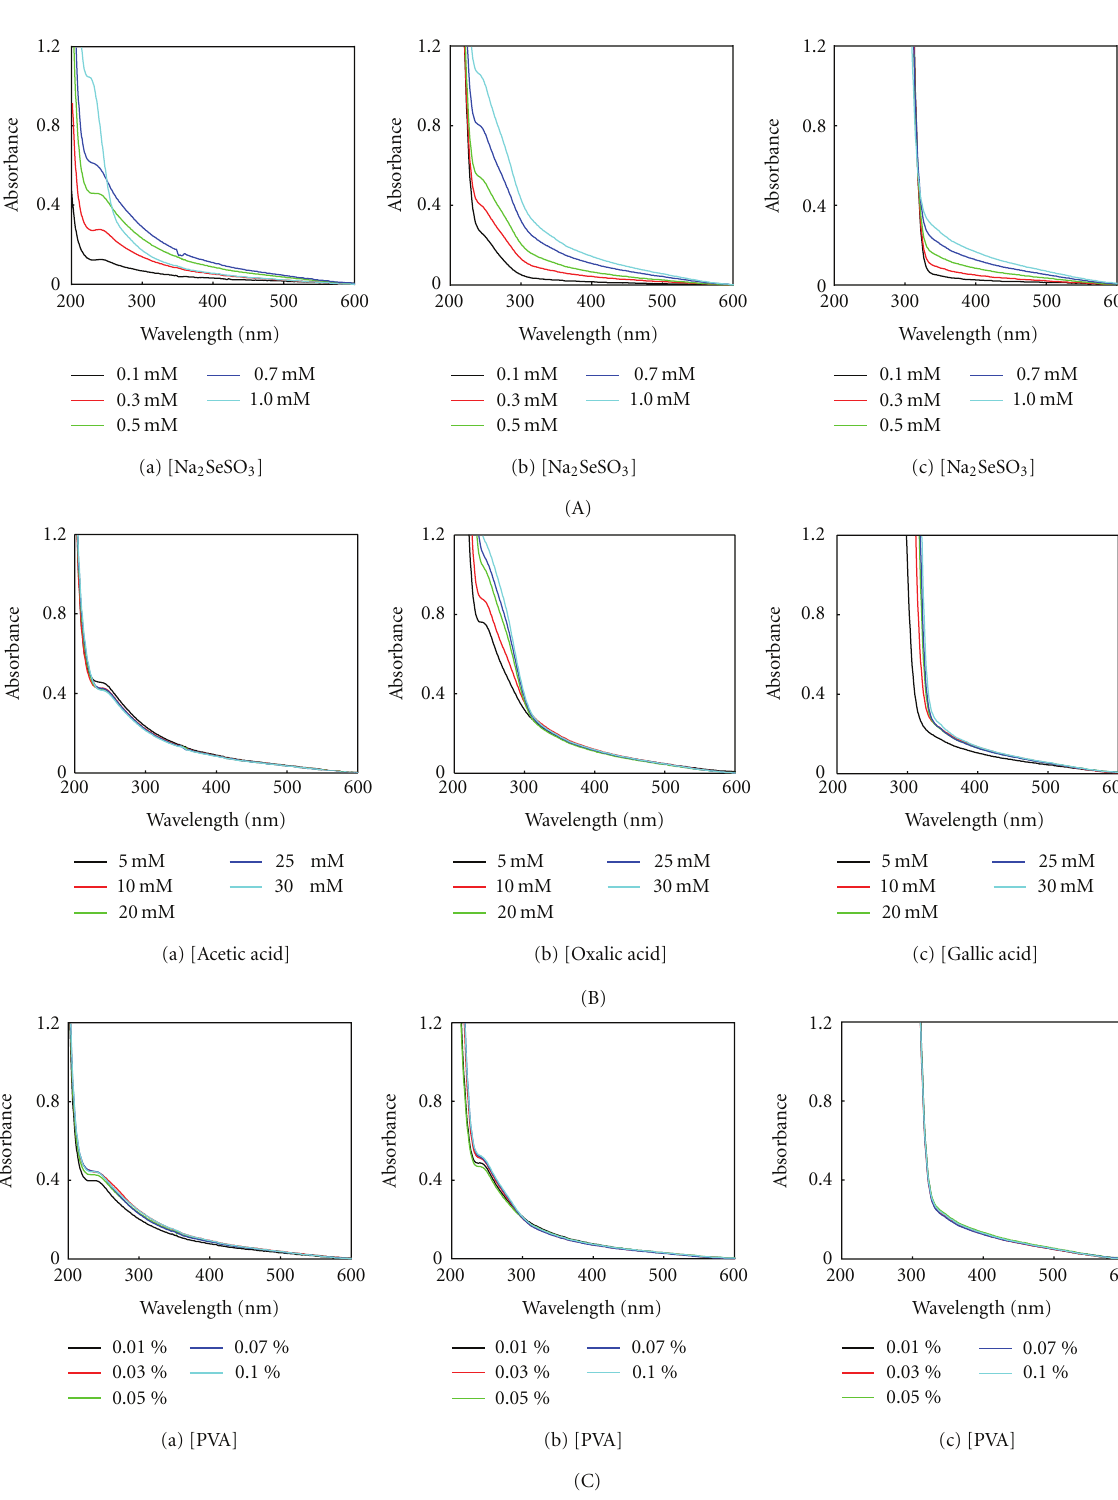
Figure 2: (A) E ff ect of sodium selenosulphate concentration on the UV-visible absorption spectra of the selenium sols produced by the reaction of sodium selenosulphate with 5 . 0 × 10 − 3 moldm − 3 (a) acetic acid, (b) oxalic acid, and (c) gallic acid, at a fixed concentration of PVA (0.05%). (B) E ff ect of acid concentration, (a) acetic acid, (b) oxalic acid, and (c) gallic acid, on the absorption spectra of the selenium sols produced by reaction with 5 . 0 × 10 − 4 moldm − 3 sodium selenosulphate, in the presence of 0.05% PVA. (C) E ff ect of PVA concentration on absorption spectra of the selenium sol produced by the reaction of 5 . 0 × 10 − 4 moldm − 3 sodium selenosulphate with 5.0 × 10 − 3 moldm − 3 (a) acetic acid, (b) oxalic acid, and (c) gallic